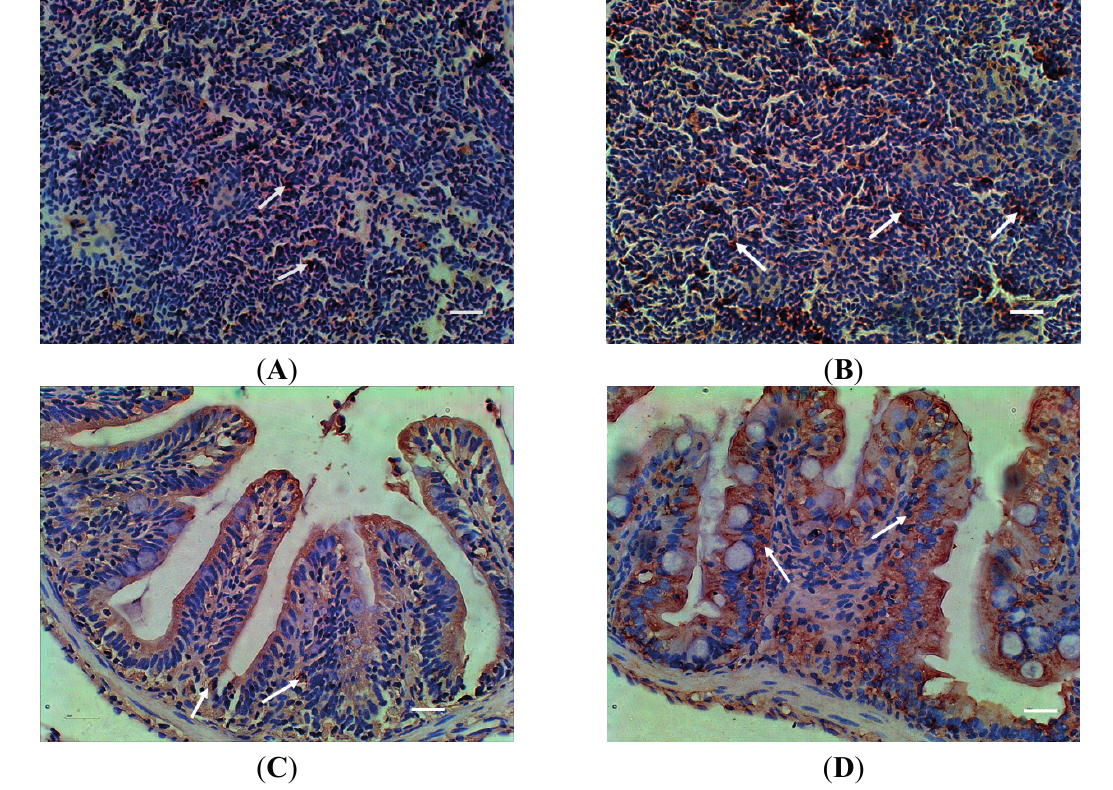
Figure 5. Distribution of MR in spleen and intestine of zebra fish detected with Immunohistochemistry after Aeromonas sobria infection. ( A ) spleen of control fish; ( B ) spleen of infected fish; ( C ) intestine of control fish; ( D ) intestine of infected fish; White arrows indicated positive signal. Scale bar = 20 μ